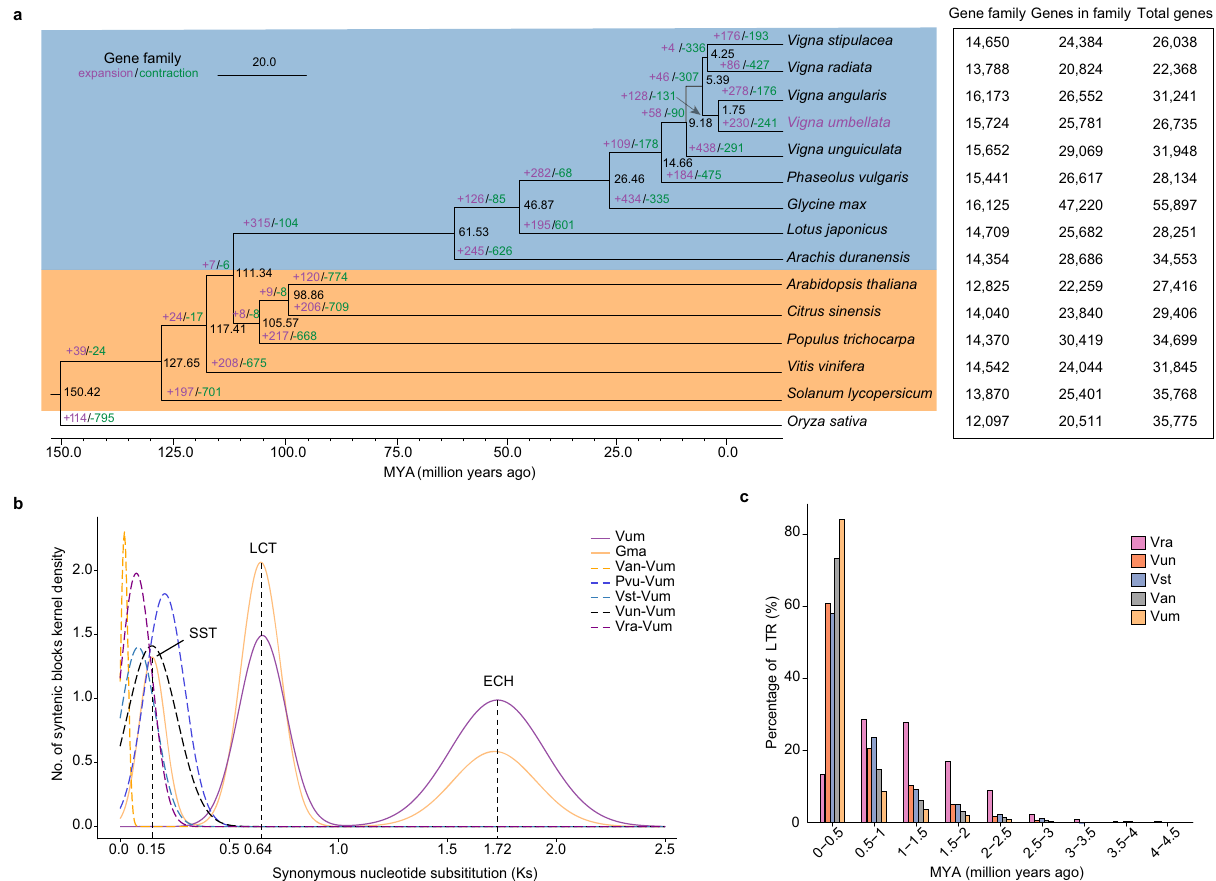
shown on the right for each species. b Density distribution of synonymous nucleotide substitution levels (Ks) of syntenic orthologous (solid curves) and paralogous genes (dashed curves). Vum: Vigna umbellata ; Gma: Glycine max ; Van: V. angularis ; Pvu: Phaseolus vulgaris ; Vst: V. stipulacea ; Vun: V. unguiculata ; Vra: V. radiata . c Insertion bursts of full-length LTR elements in the genomes of V. umbellata and other four Vigna species. Source data are provided as a Source Data fi